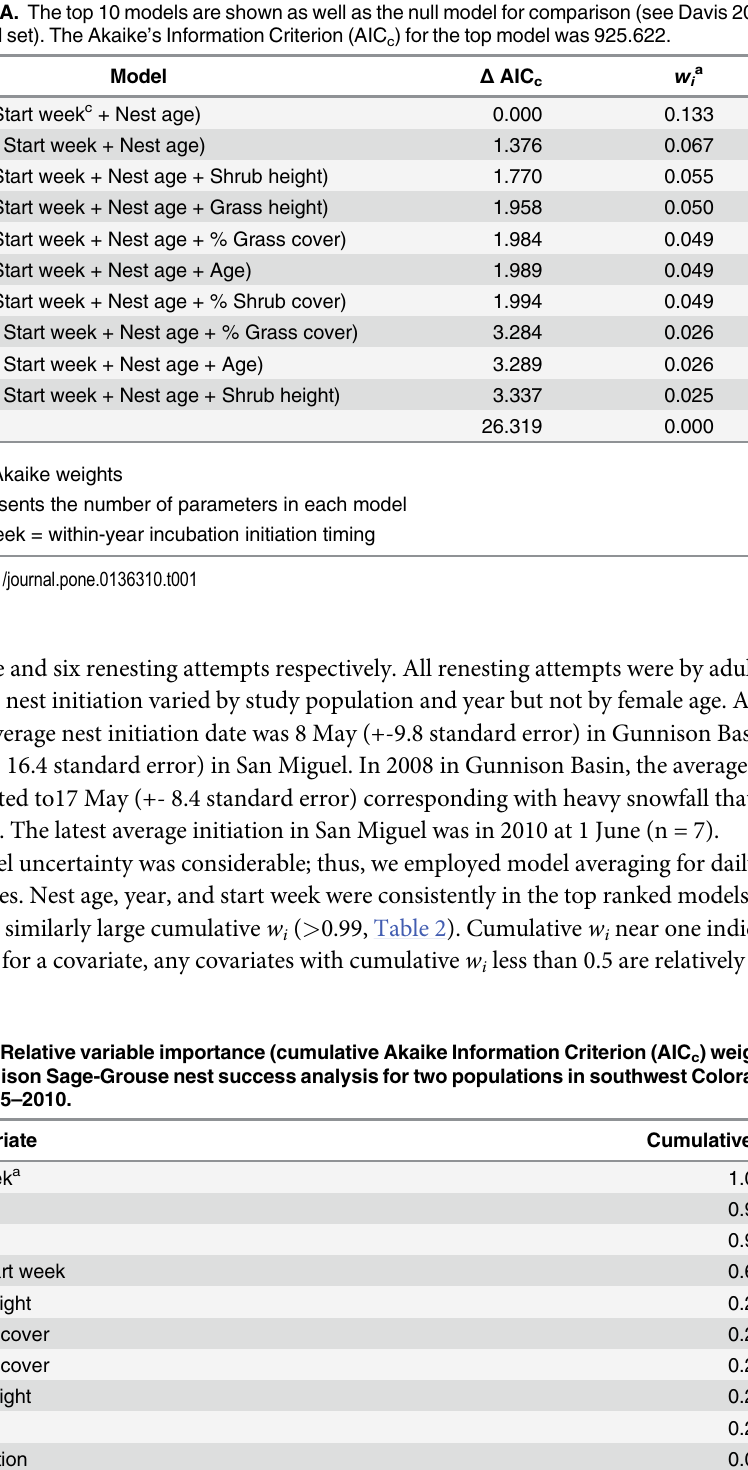
Table 1. Gunnison Sage-Grouse nest success models from 2005 – 2010 in two populations in Colo- rado, USA. The top 10 models are shown as well as the null model for comparison (see Davis 2012 for the full model set). The Akaike ’ s Information Criterion (AIC c ) for the top model was 925.622. Model Δ AIC c w i a K b S(Year * Start week c + Nest age) 0.000 0.133 19 S(Year + Start week + Nest age) 1.376 S(Year * Start week + Nest age + Shrub height) 1.770